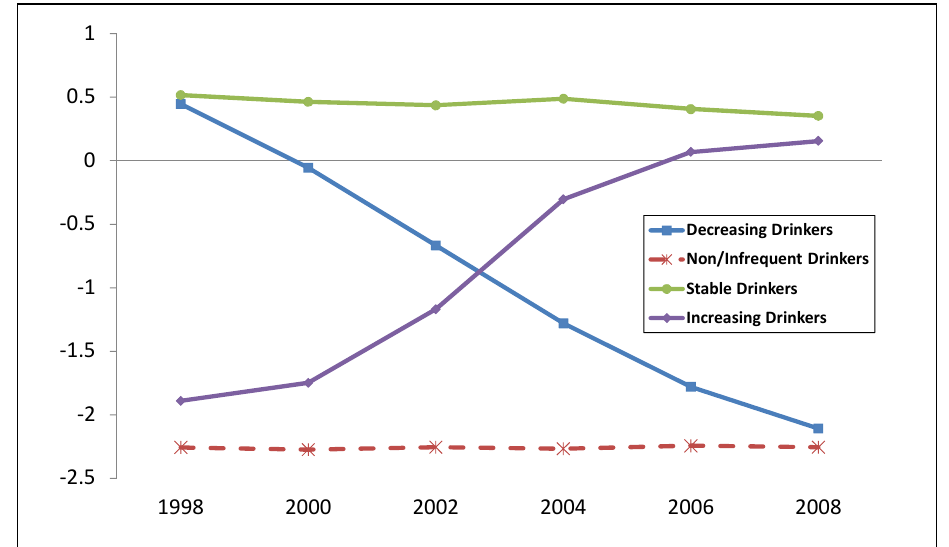
Figure 1. Alcohol use trajectories among 4,439 women in the HRS ages 50–65 years in 1998 based on number of drinks per drinking day (log